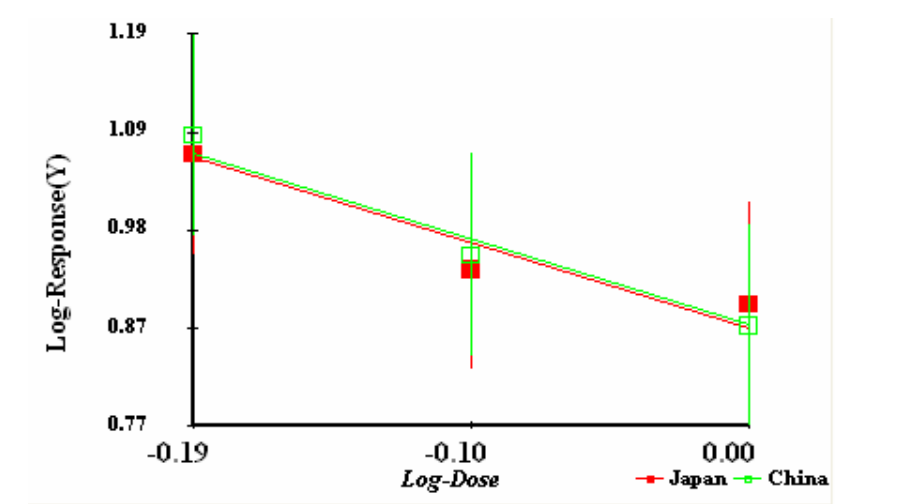
Figure 6: Slope function and parallelism of the hemorrhagic neutralization of Agkistrodon halys venom by Agkistrodon halys (Japan) and Jiangzhe Agkistrodon halys (China) antivenoms.